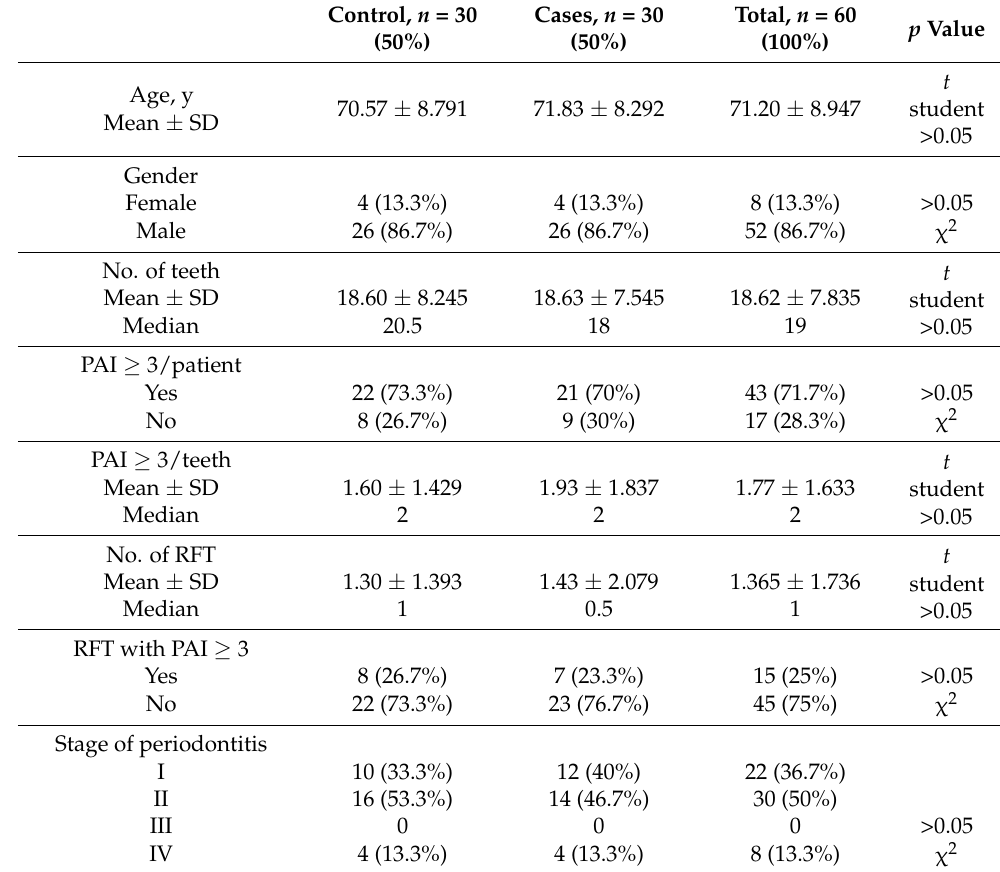
Table 2. Distribution of the study factors in both control and case